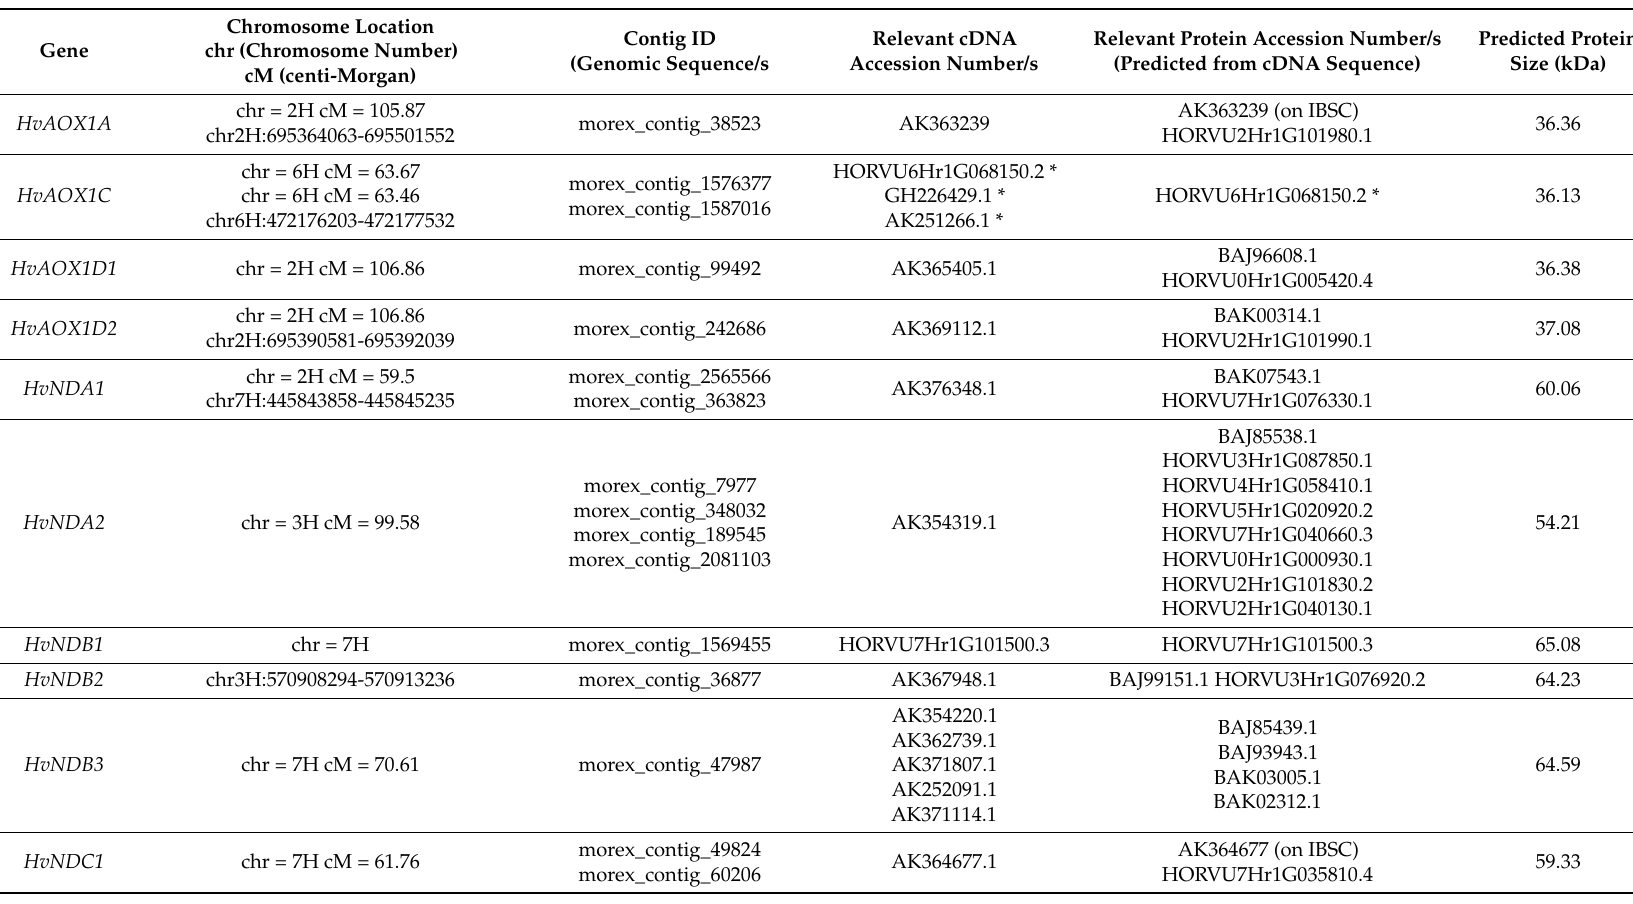
Table 1. Alternative respiratory pathway components identified in barley. HvAOX1a , HvAOX1d1 and HvAOX1d2 cDNA sequences as well as a HvAOX1c EST sequence were identified in Costa et al., 2014. BLAST servers from NCBI (National Centre for Biotechnology Information) and IBSC (International Barley Sequencing Consortium) were used to find barley sequences with high homology with the rice alternative dehydrogenase sequences identified in [3,24]. Chromosome location as well as genomic sequences (contigs) were found using IPBC. * are partial